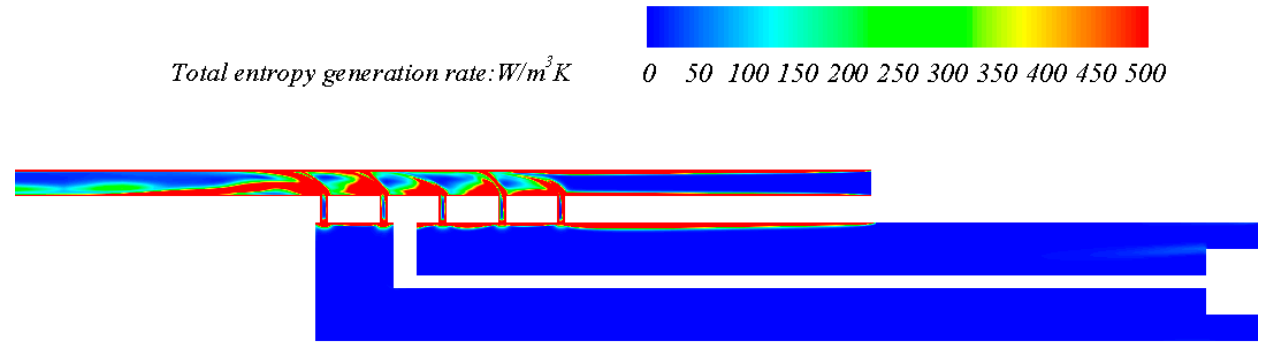
Figure 19. Total entropy generation rate in the fluid domain ( x = 28.5 mm, DSJ off).